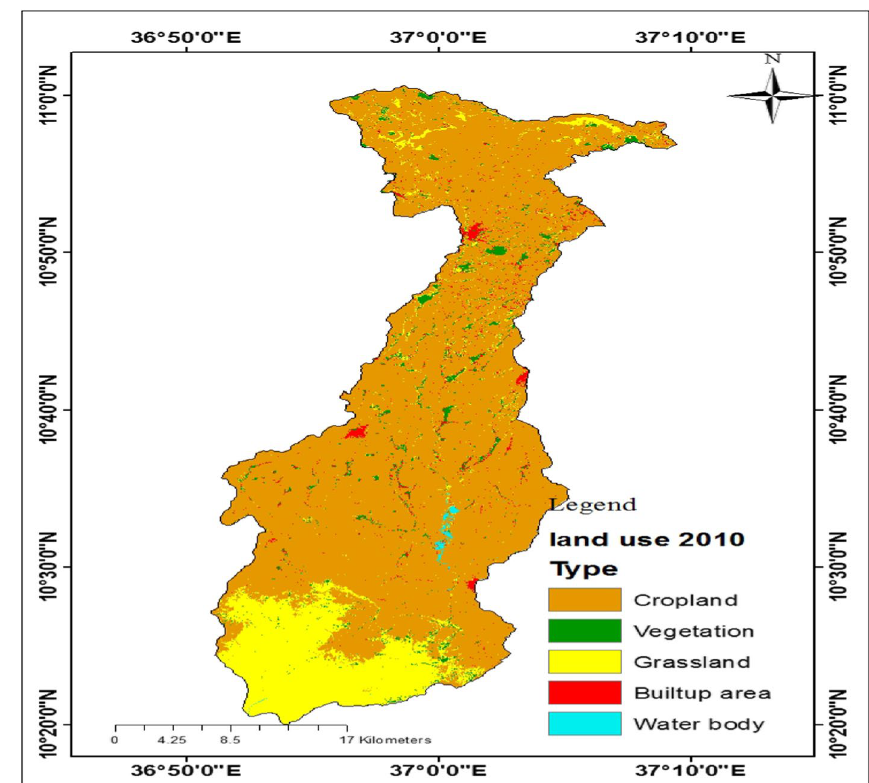
Fig. 8 A map showing land use and land cover in